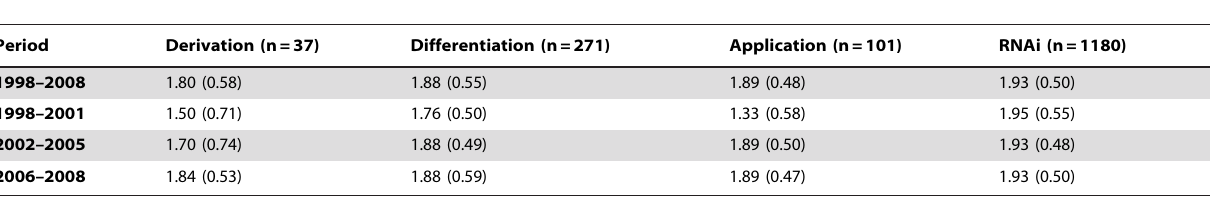
Table 2. Policy Similarity between the US and Collaborating